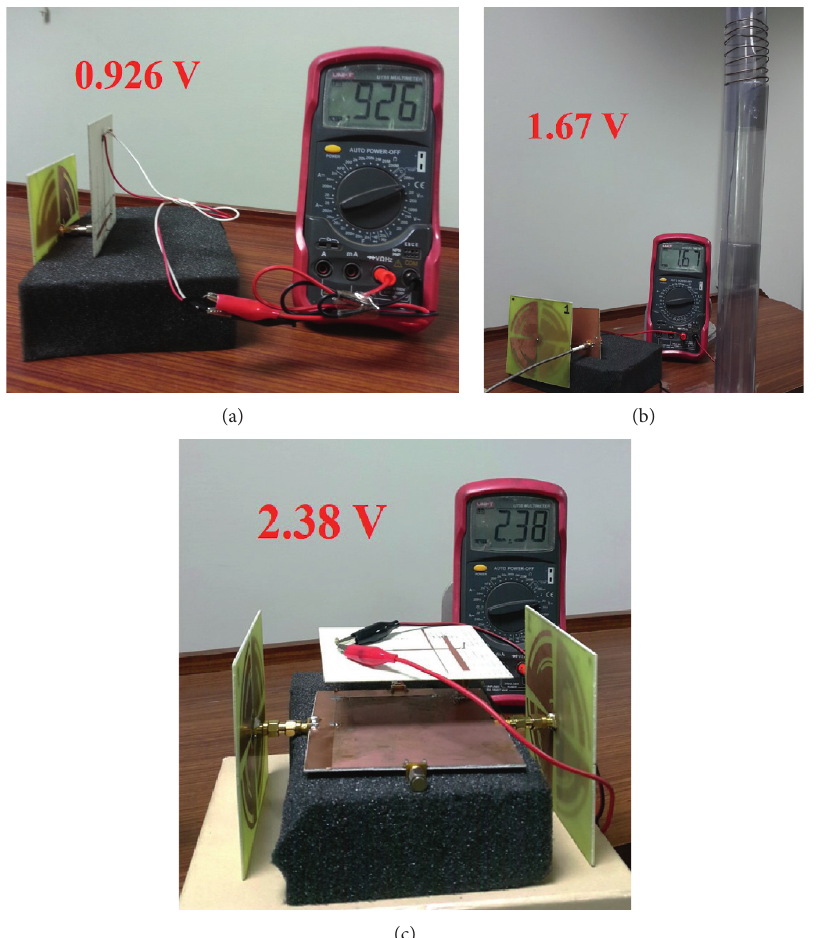
Figure 32: Dedicated testing setup for the rectenna at − 10dBm input power using (a) single multiband antenna element, (b) single multiband antenna element combined with FM rectenna, and (c) two multiband antenna elements (all measurements have been conducted with multitone